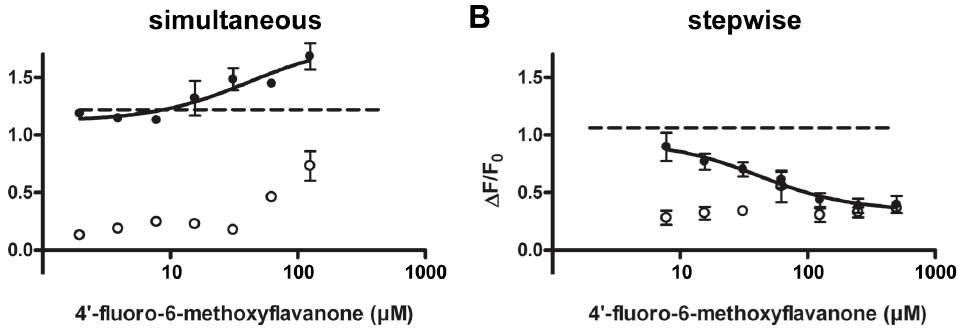
N ), non-induced ( # )) by 4 9 -fluoro-6-methoxyflavanone